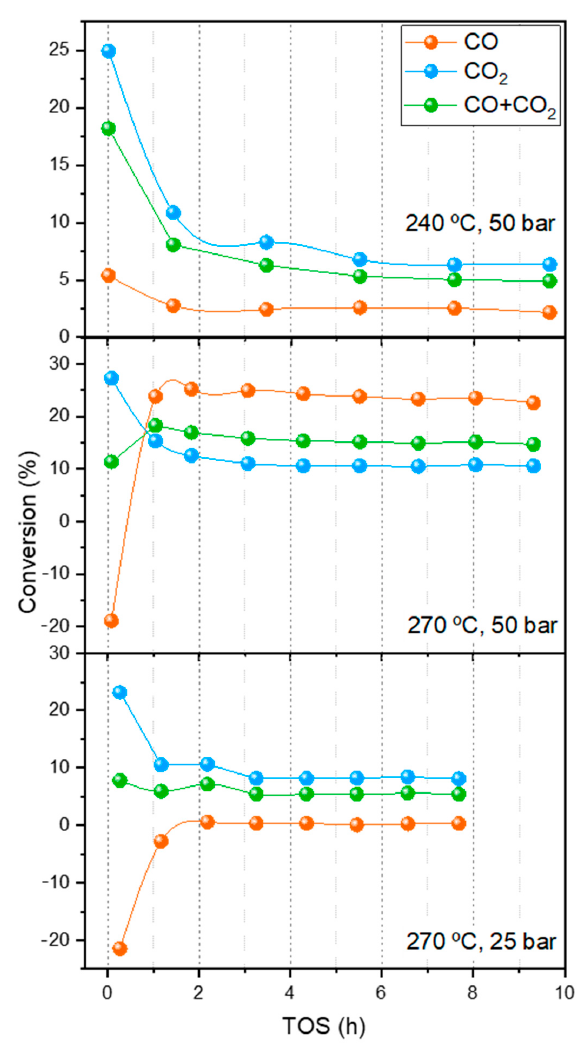
Figure 7. Evolution of conversion results with TOS in the r-WGS-3A-MeOH configuration at different conditions. GHSV = 7500 h − 1 . In contrast, at 240 ◦ C, CO conversions are always positive, but decrease with